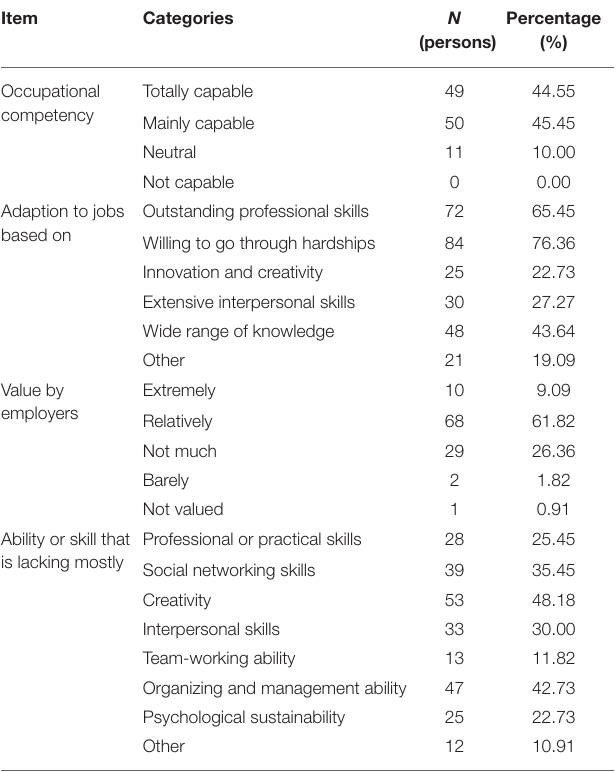
TABLE 5 | Occupational competency and value by employers of PHPM Master’s